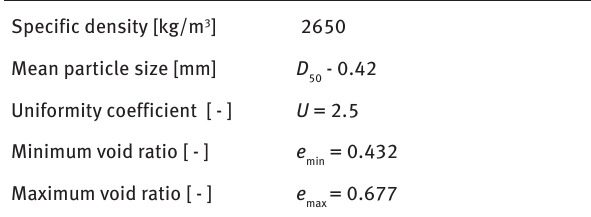
Table 1: Parameters of Skarpa